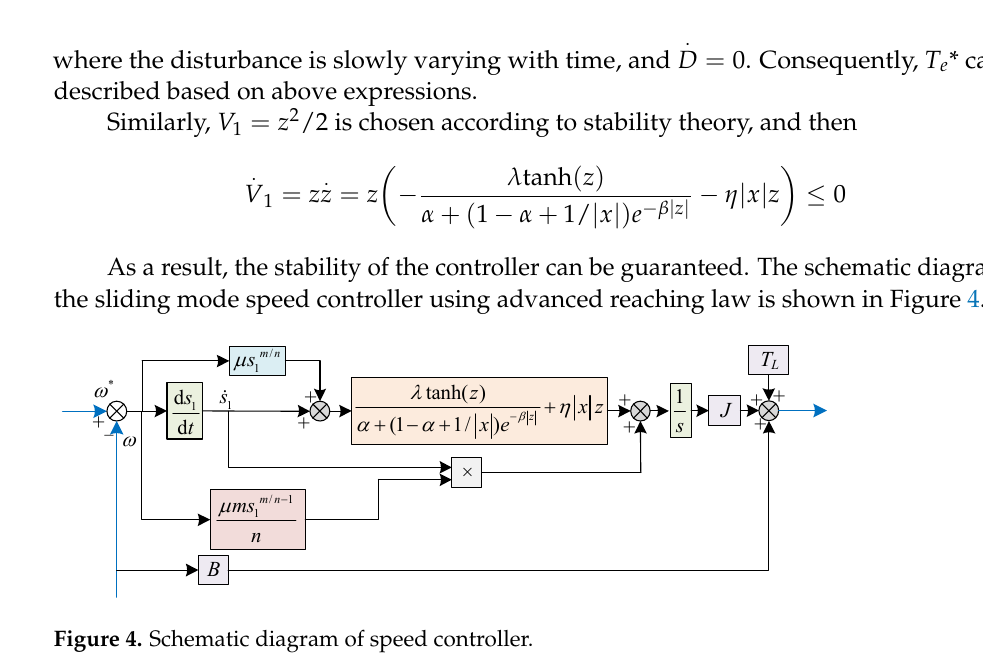
Figure 4. Schematic diagram of speed controller.